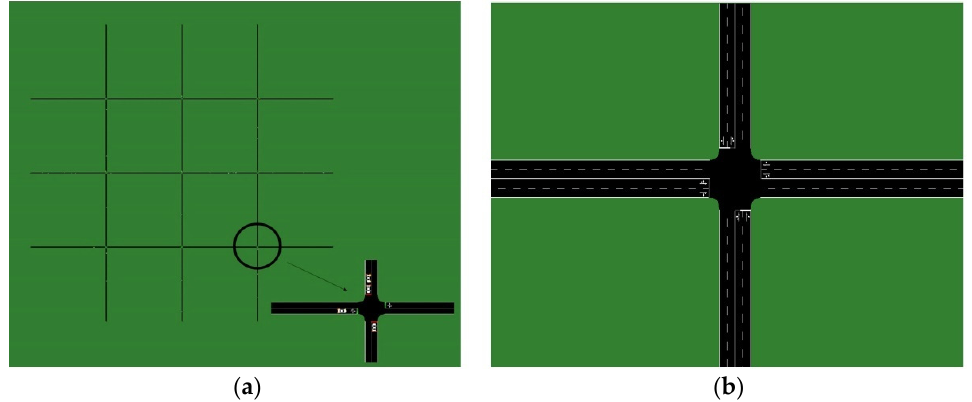
Figure 4. Case studies: ( a ) Signalized grid network; ( b ) shows Unsignalized intersection.